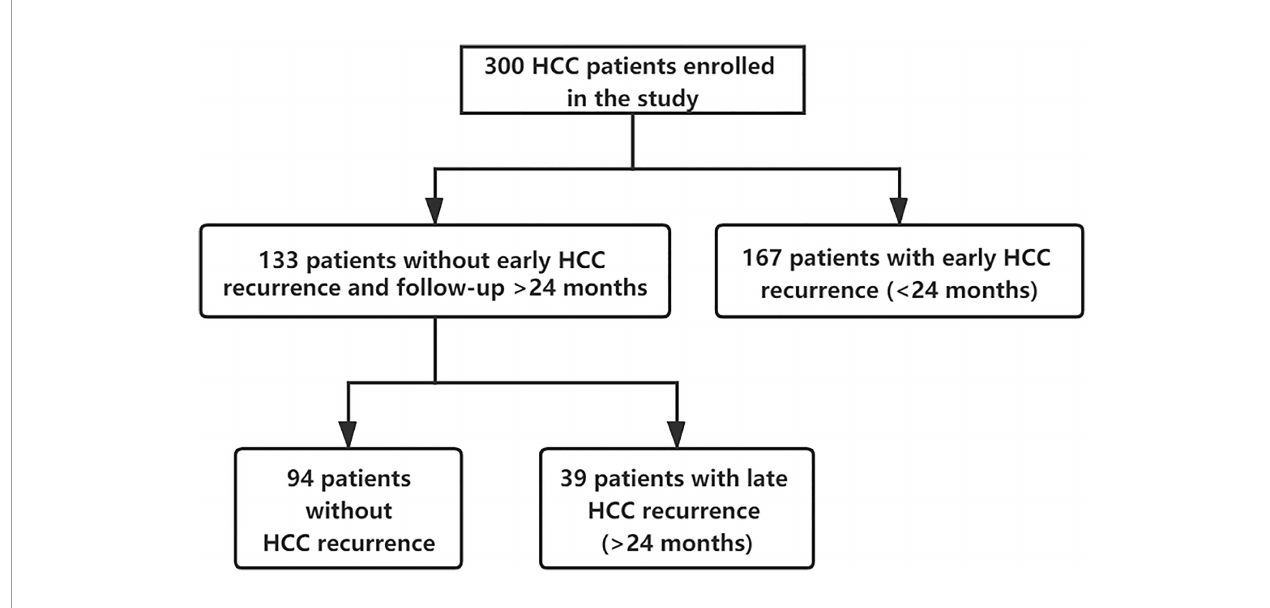
FIGURE 2 | Flowchart of this study.